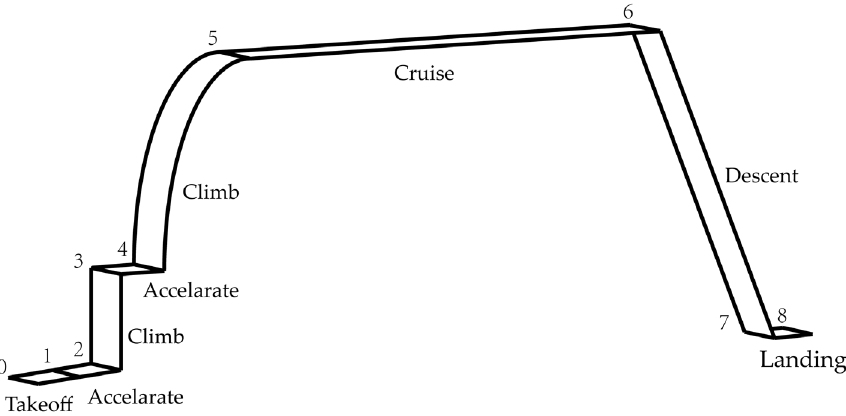
Figure 1. Mission profile of the illustrative aircraft.